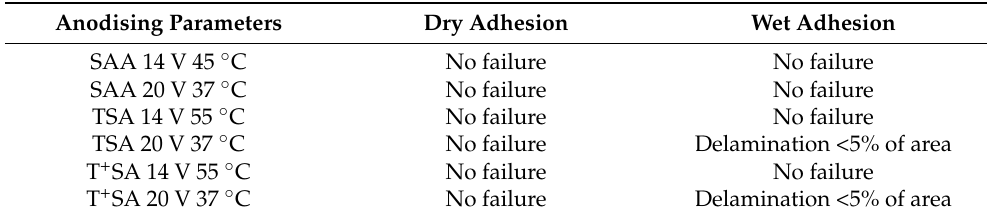
Table 5. Results of the cross-cut test for the Cr(VI)-free model primer in dry condition and after two weeks of immersion in deionised water.